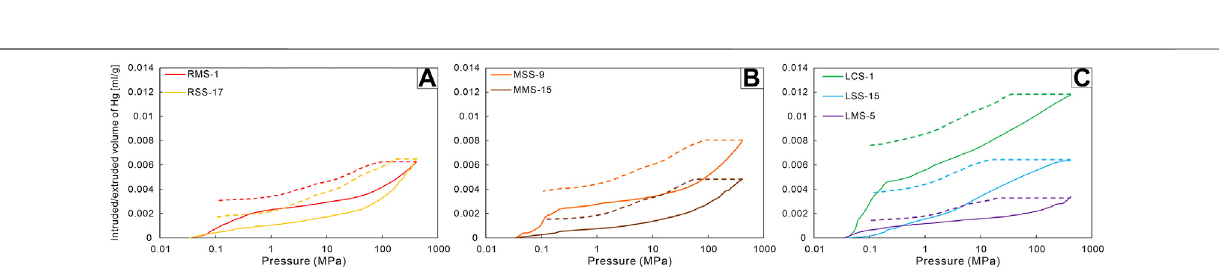
Frontiers in Earth Science |